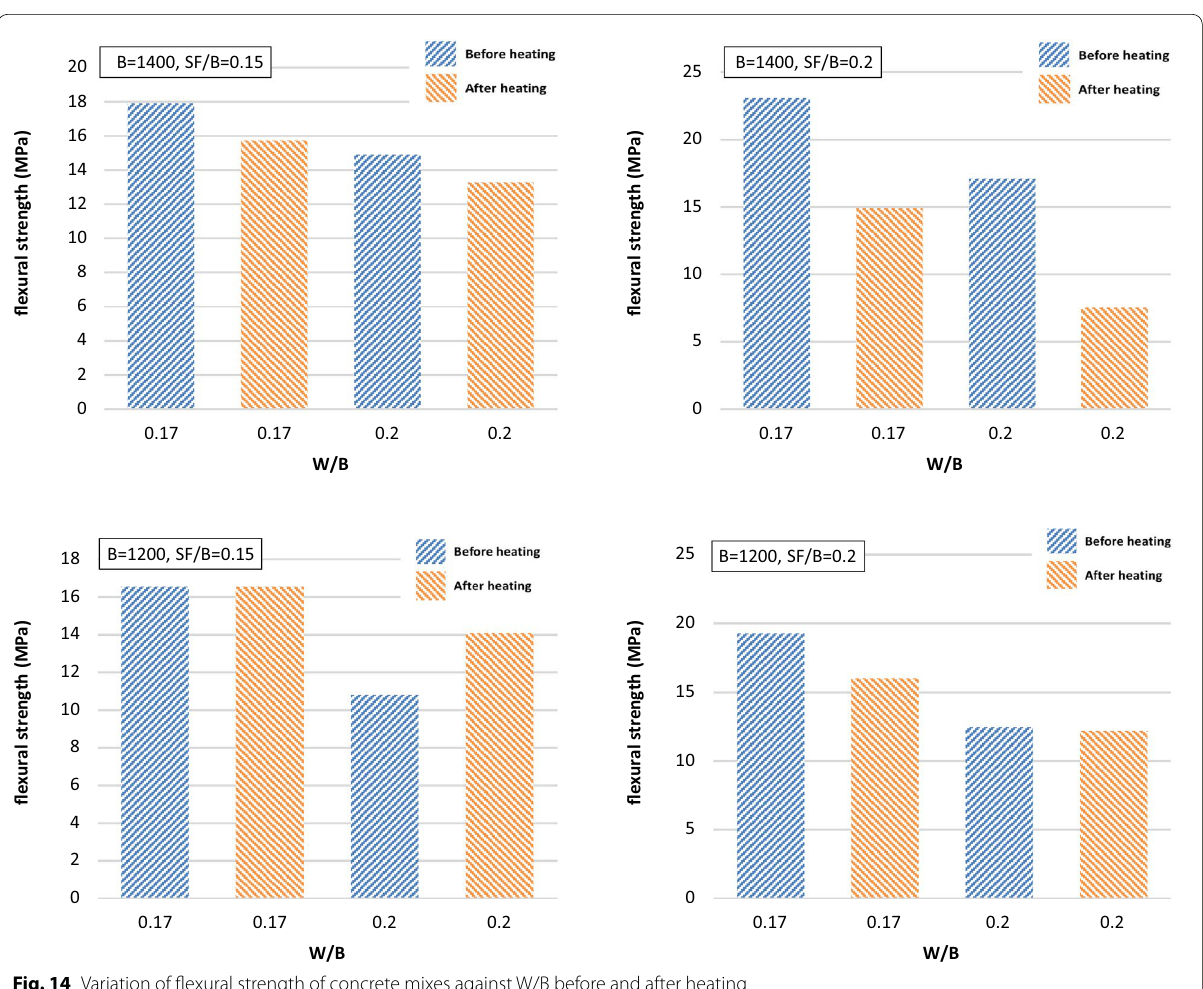
Fig. 14 Variation of flexural strength of concrete mixes against W/B before and after heating